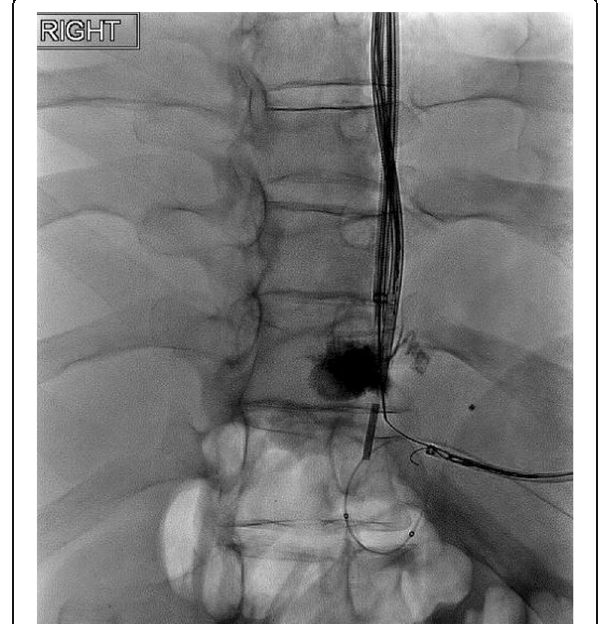
Fig. 4 Fluoroscopic image showing a V18 wire (which was introduced through the Chiba needle) was then snared within the